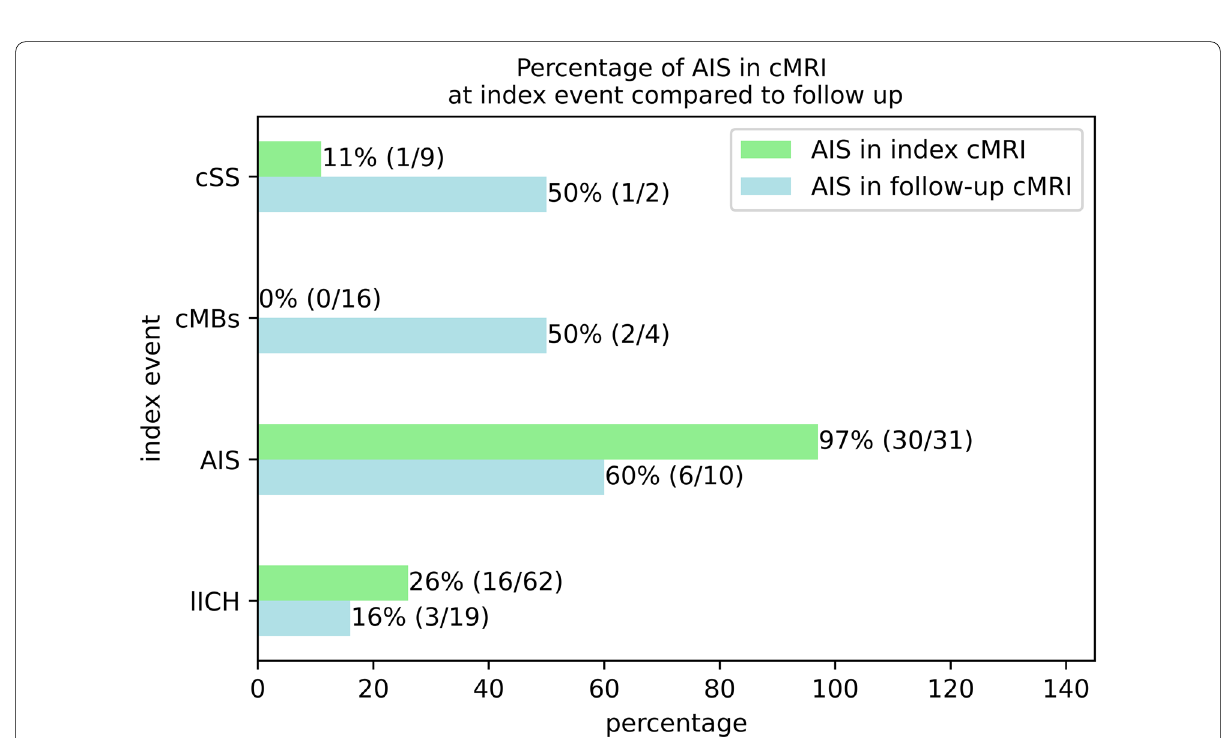
Fig. 4 Percentages of AIS in cMRI at index event and in follow up, grouped by index event (numbers in parentheses: affected and overall